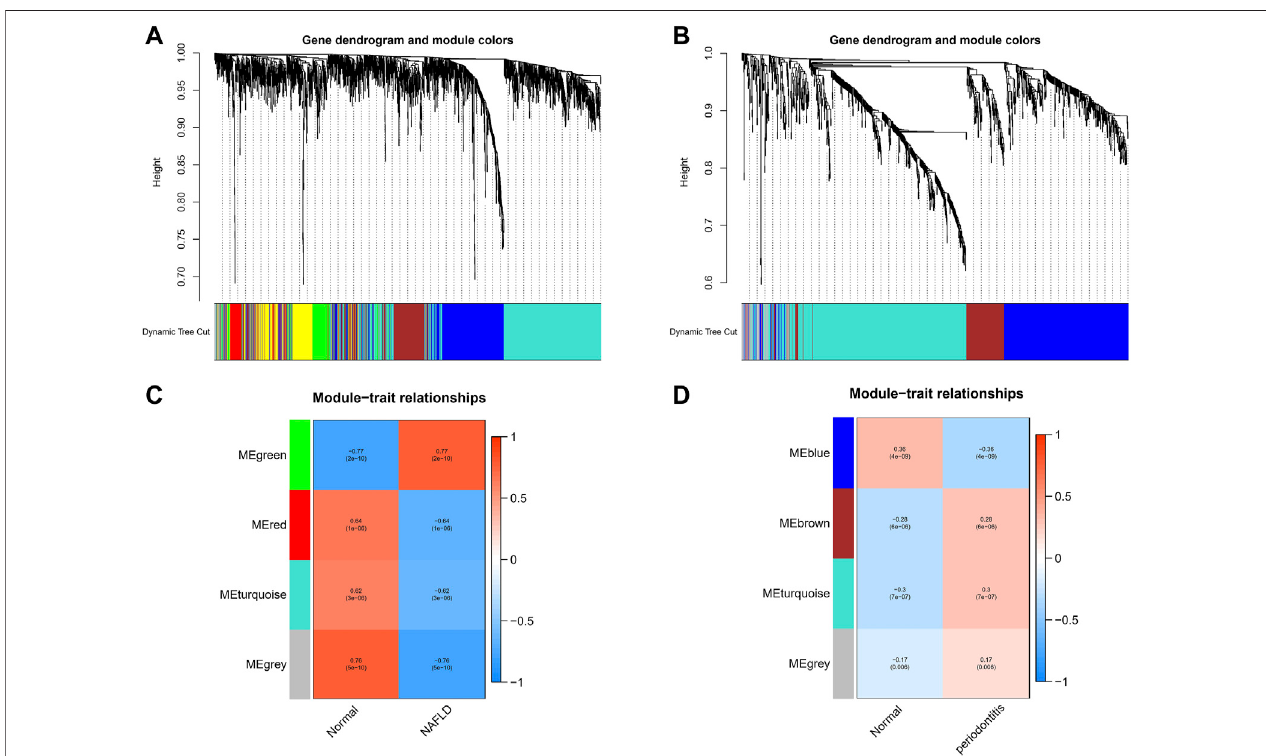
FIGURE1| Weightedgeneco-expressionnetworkanalysis(WGCNA). (A) Theclusterdendrogramofco-expressiongenesinNAFLD. (B) Theclusterdendrogram of co-expression genes in periodontitis. (C) Module – trait relationships in NAFLD. Each cell contains the corresponding correlation and p -value. (D) Module – trait relationships in periodontitis. Each cell contains the corresponding correlation and p -value. NAFLD, nonalcoholic fatty liver